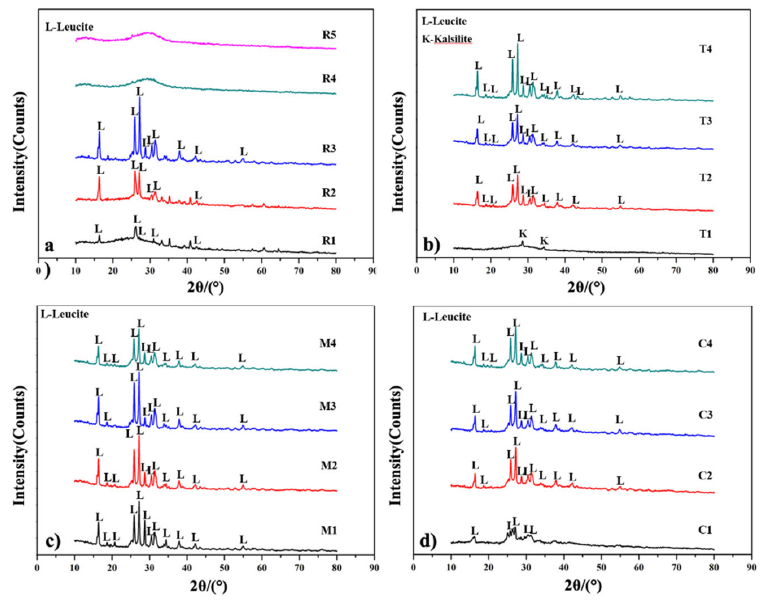
Figure 2. The results of XRD under different ( a ) alkaline solution ratios, ( b ) calcining temperatures, ( c ) mixing times, and ( d ) curing times. ( c ) mixing times, and ( d ) curing